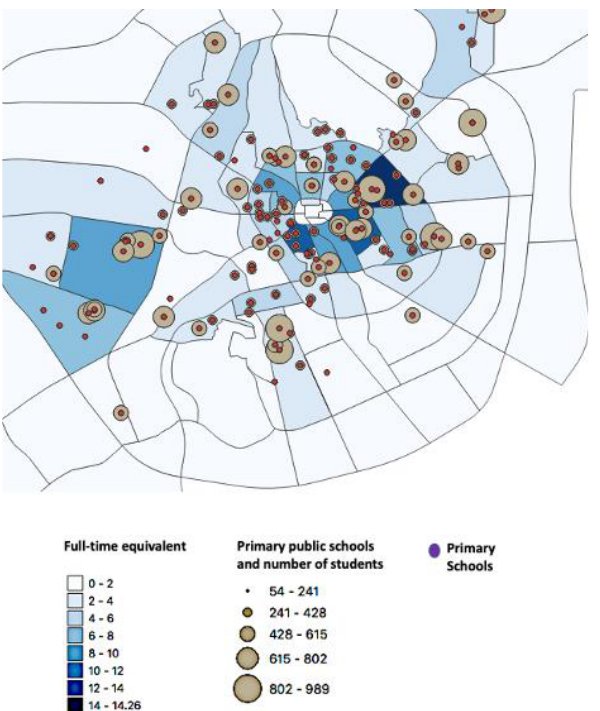
Figure 3. Model 2: a geographic model for school dental services (SDS) in Al-Madinah city presenting the distribution of full-time equivalent for SDS for each district.